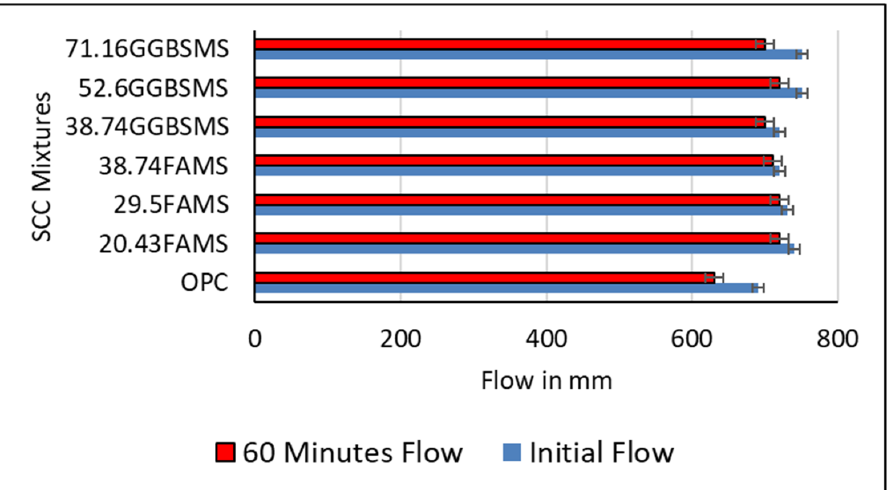
Figure 9. Slump-flow results for SCC.